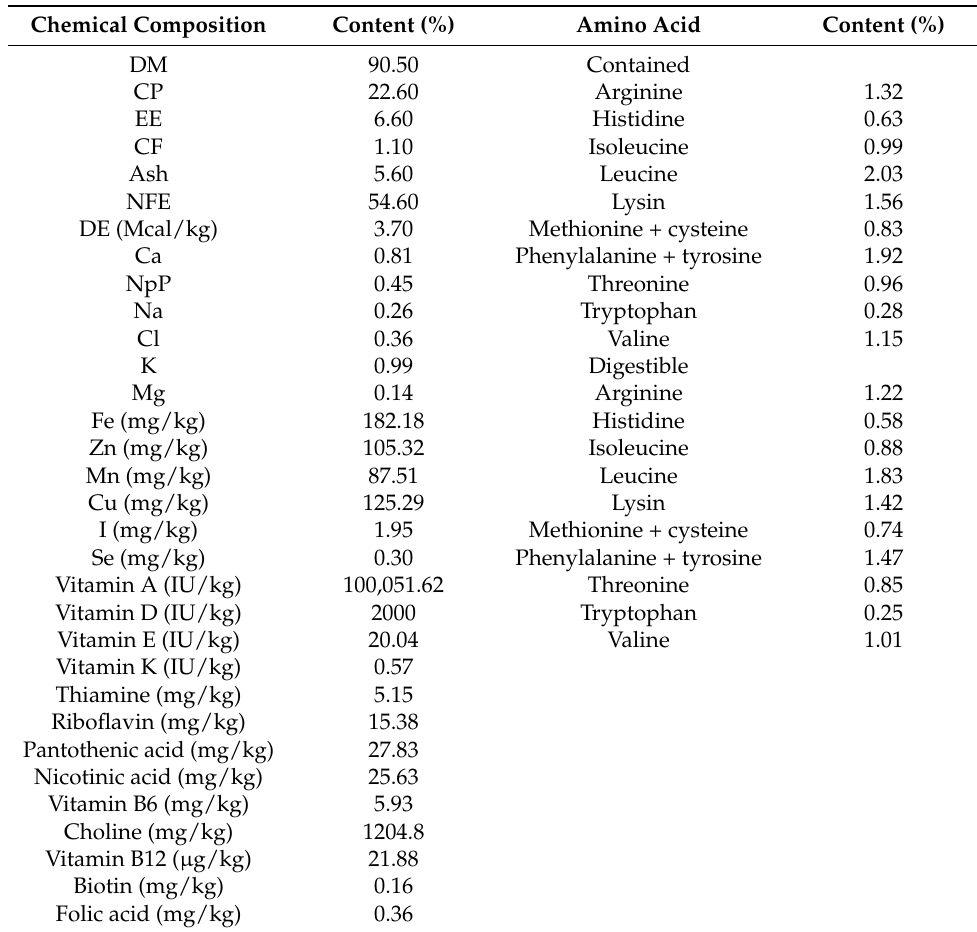
Table 4. Chemical composition of basal